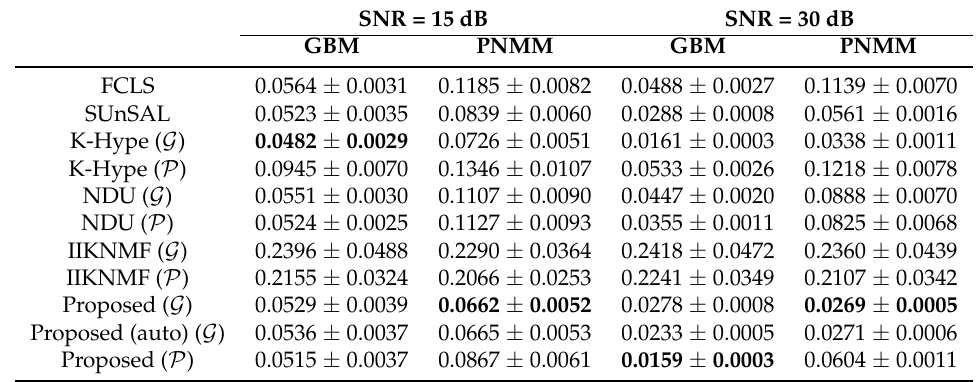
Table 2. RMSE comparison of S 2